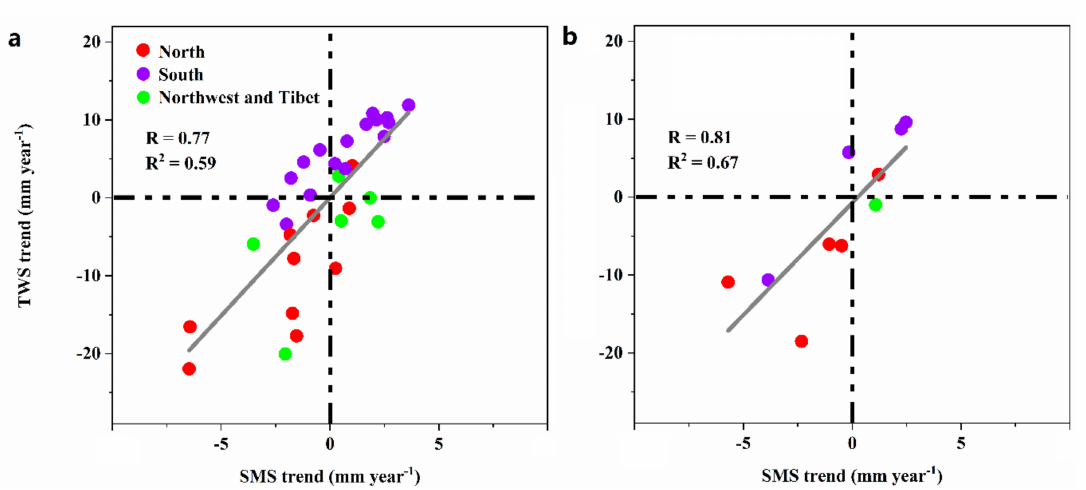
Figure 3. Relationship between the terrestrial water storage trends and soil moisture storage trends during 2003–2016. ( a ) Per the province. ( b ) Per the basin. At the provincial level, North refers to Beijing, Tianjin, Hebei, Henan, Shandong, Inner Mongolia, Shanxi, Heilongjiang, Jilin, and Liaoning; South refers to Jiangsu, Zhejiang, Shanghai, Anhui, Jiangxi, Fujian, Hubei, Hunan, Sichuan, Chongqing, Guizhou, Yunnan, Guangdong, and Guangxi; Northwest and Tibet refers to Shanxi, Gansu, Ningxia, Qinghai, Xinjiang, and Tibet. At the watershed level, North refers to the Yellow River, Haihe River, Huaihai River, Liaohe River, and Songhua River; South refers to the Yangtze River, Pearl River, Southeast, and Southwest River; Northwest and Tibet refers to the Northwest rivers.